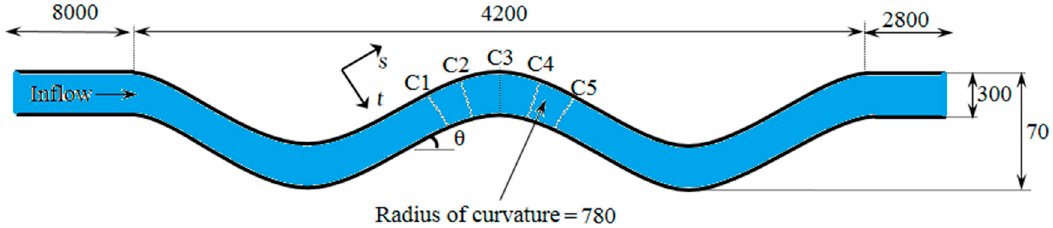
Figure 1. Top view of the experimental setup and bend reach and measurement sections (all dimensions are in mm, not in scale).